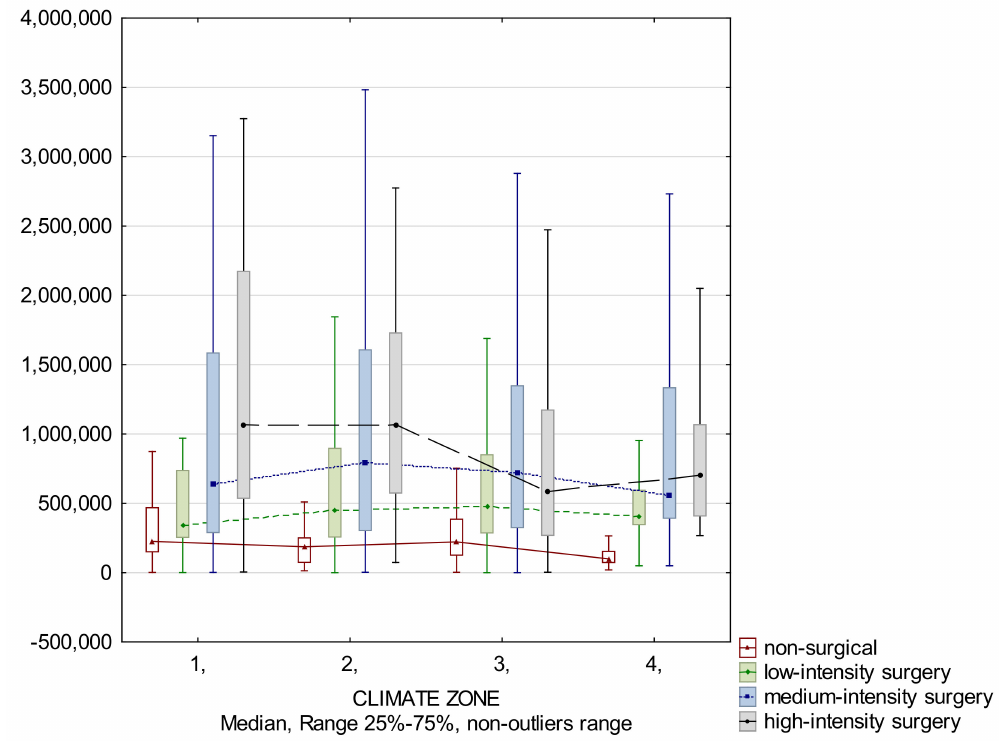
Figure 10. TEC by hospital surgery intensity related to climate zones in